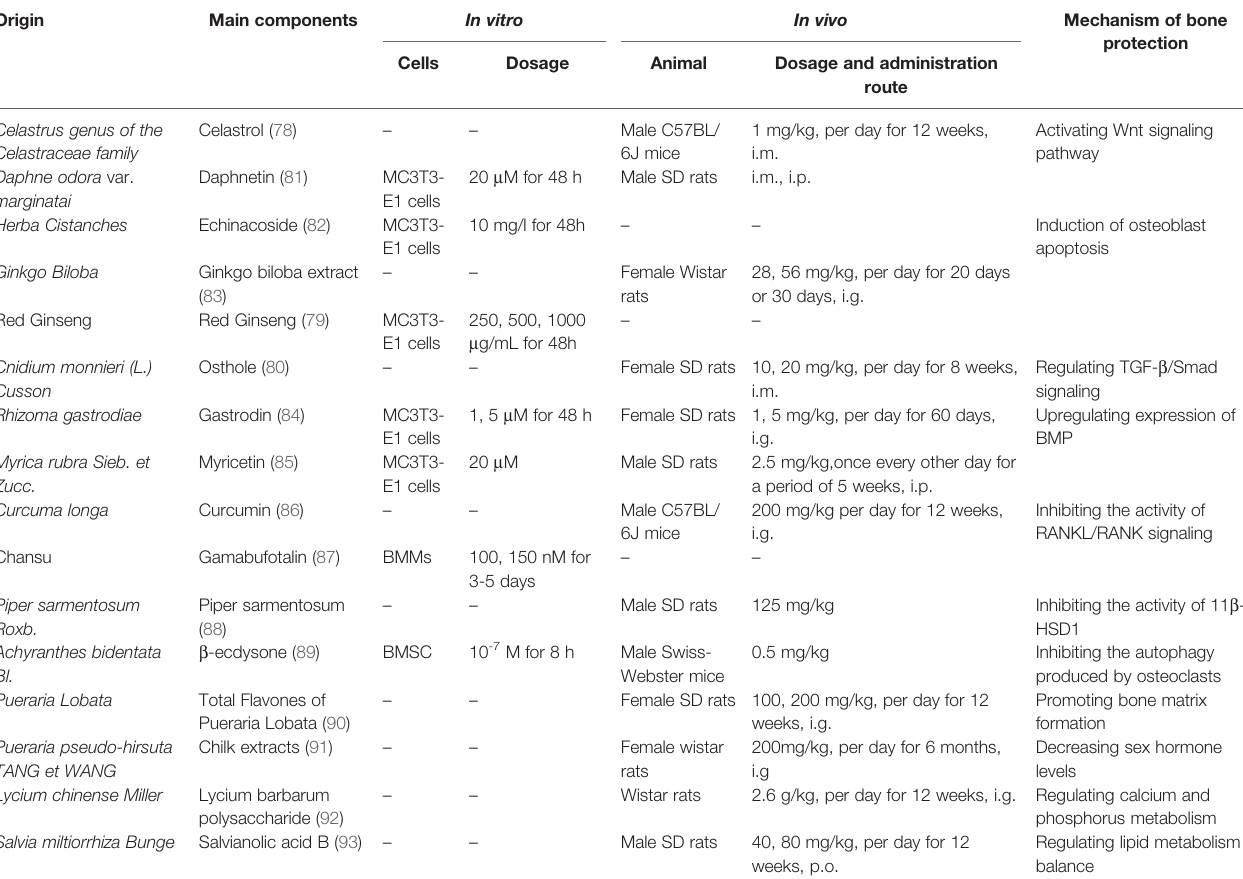
TABLE 1 | Herbal medicines capable of inhibiting or treating